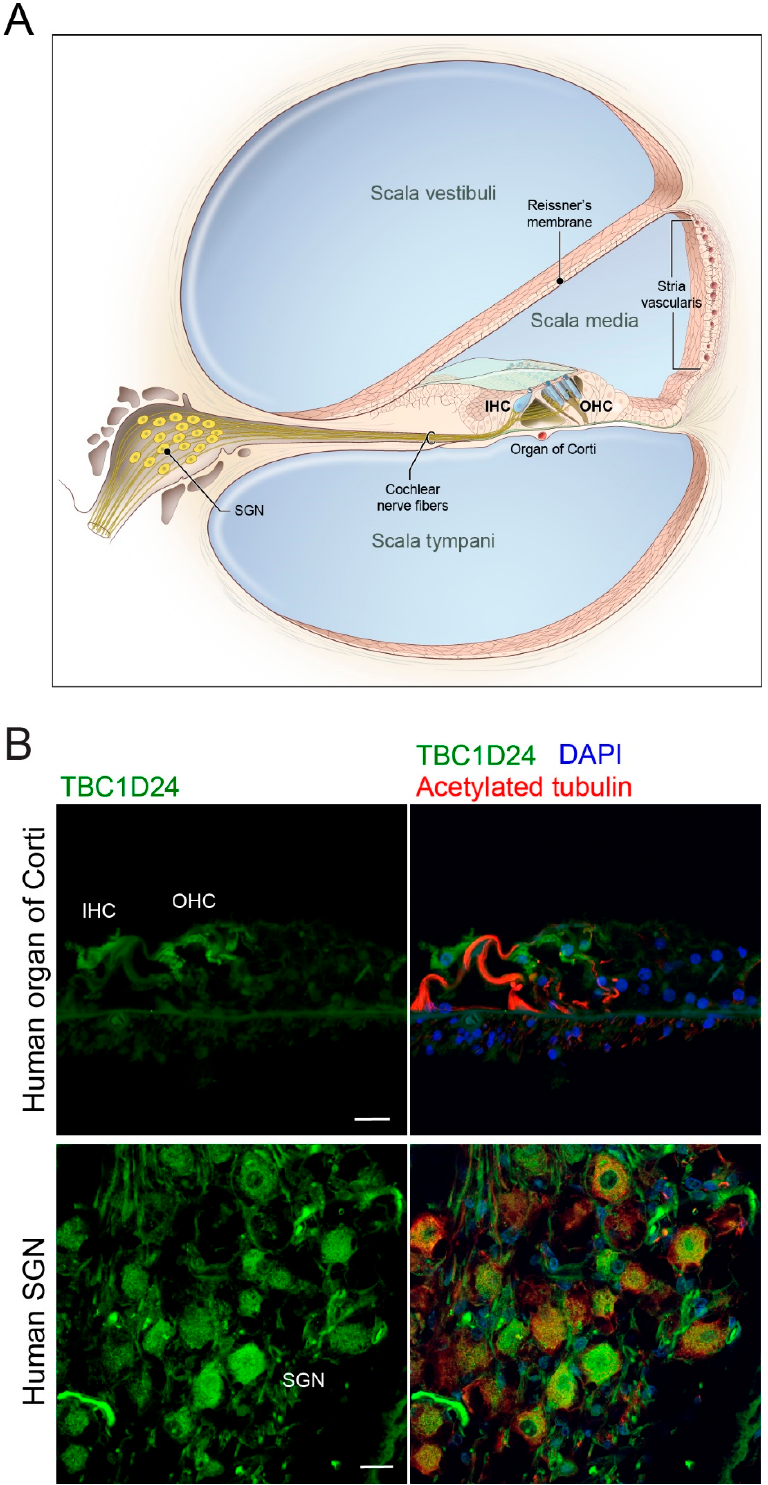
Figure 3. TBC1D24 expression in spiral ganglion neurons (SGN) and organ of Corti from human temporal bones. ( A ) Drawing of a cochlea in cross-section including the organ of Corti and SGN. The organ of Corti contains various supporting cells, one row of inner hair cells (IHC) and three rows of outer hair cells (OHC). ( B ) Representative images of localization of TBC1D24 in human temporal bone cross-sections. TBC1D24 is detected in an IHC and OHC (upper panels) and SGN (lower panels). Scale bars are 20 µm.